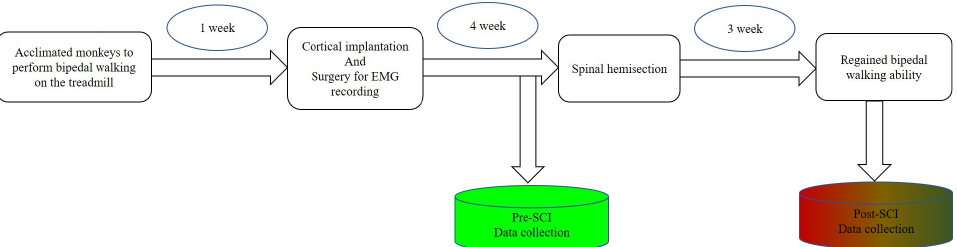
Figure 3. Sequence flows of surgical procedures and data collection. Blue color represents pre-SCI phase; gradient colors represent post-SCI